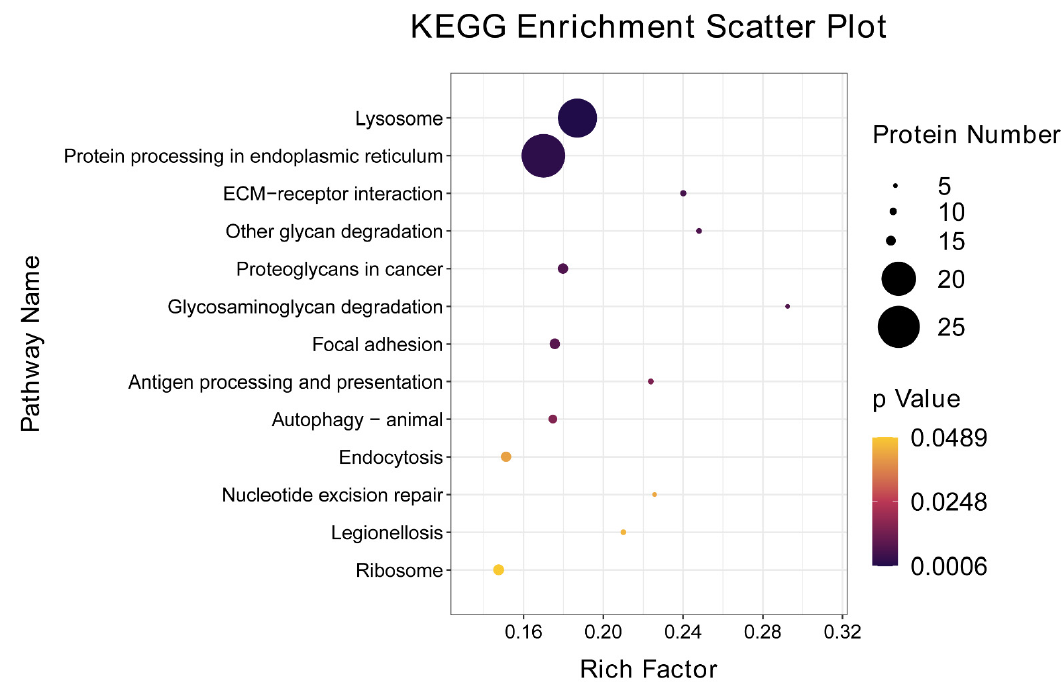
Figure 3. Significant enrichment of KEGG pathways ( p < 0.05) for DEPs in the Chinese mitten crab infected with P. gregaria .